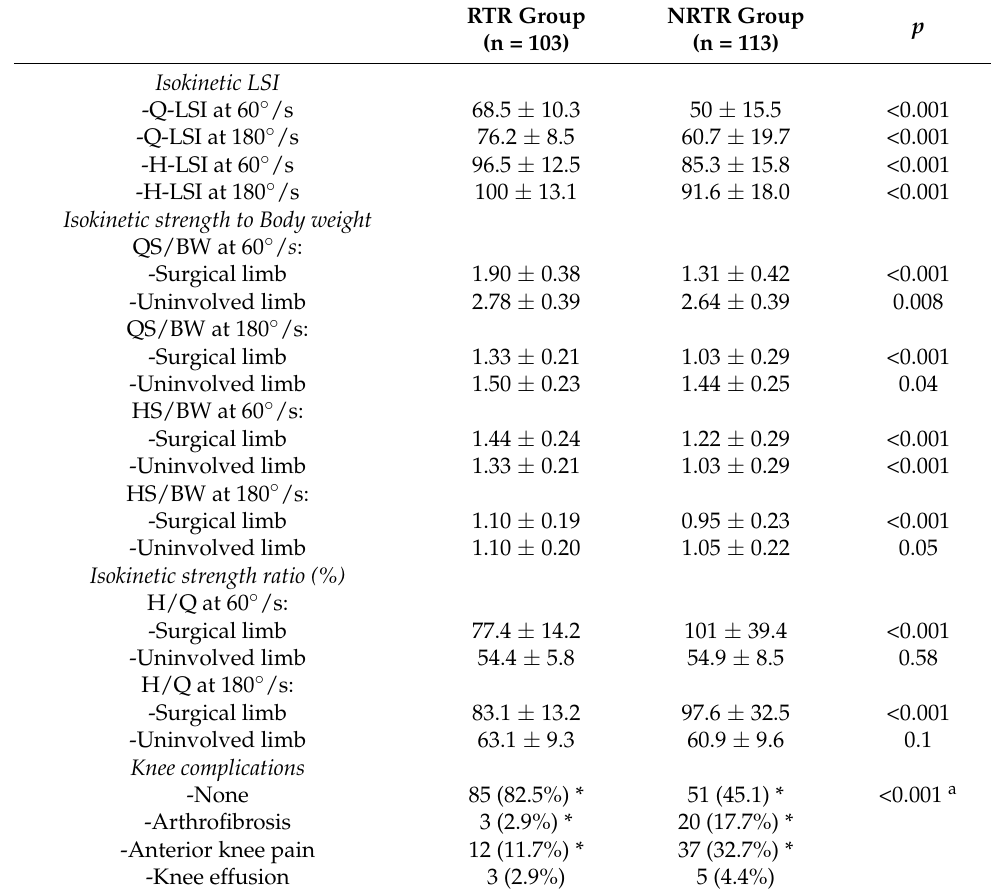
Table 2. Comparisons of isokinetic parameters and knee complications between the group of patients who returned to running (RTR group) and those who did not (NRTR